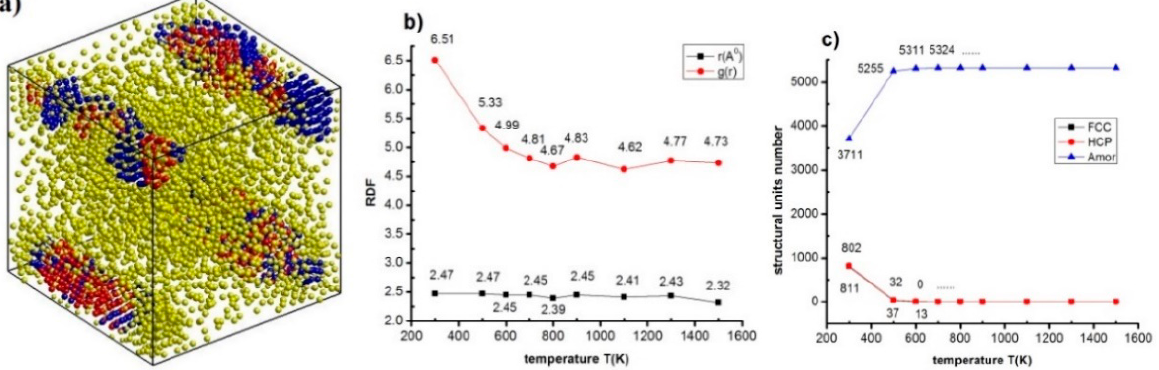
Figure 6. The structural characteristics as structural shape ( a ) of NiAu 5324 alloy at T = 300 K; RDF ( b ) and structural unit number ( c ) at different T.